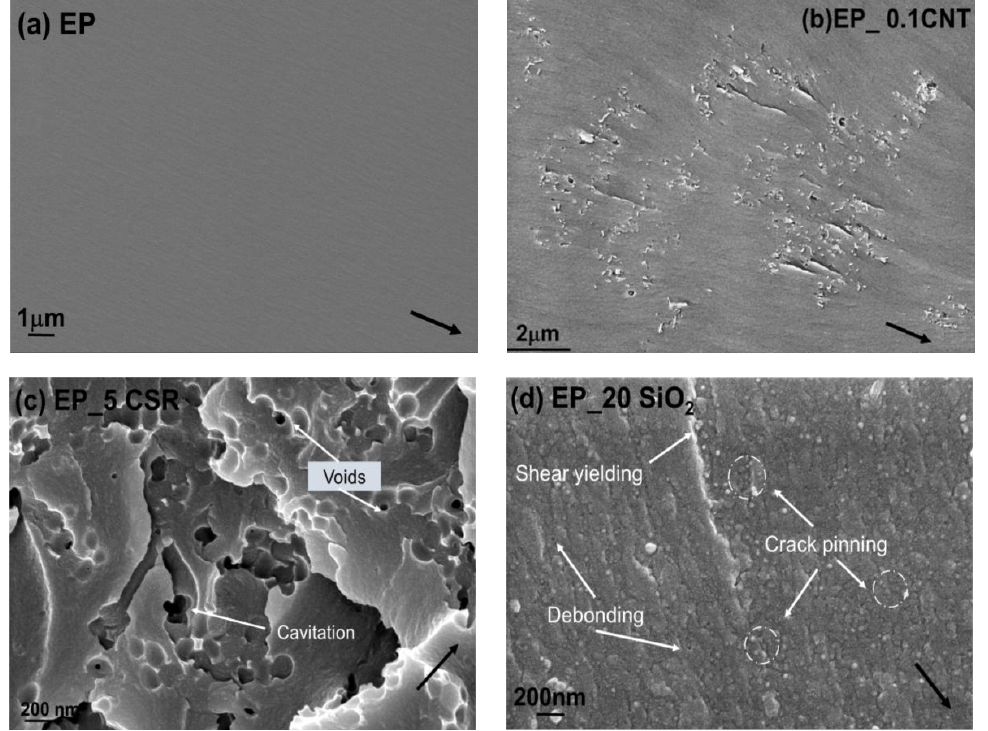
Figure 3. SEM micrographs of the fracture surface of the different reference and modified nanocomposite systems. Black arrow indicating the direction of crack propagation. ( a ) EP; ( b ) EP_0.1CNT; ( c ) EP_5CSR; ( d ) EP_20 SiO 2 .